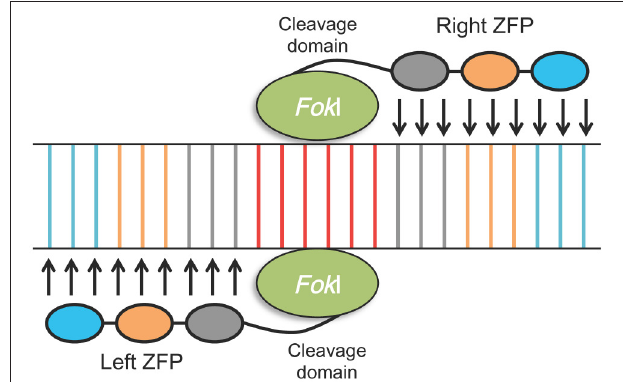
FIGURE 4 | Schematic illustration of zinc-finger nuclease (ZFN) structure and mechanism of inducing double strand breaks (DBSs) on its target. The target site of the ZFN is recognized by the “left” and “right” monomers consisting of a tandem array of three to six engineered zinc finger proteins (ZFPs) (three are shown here); single engineered ZFP can recognize a nucleotide triplet (shown in different colors). Each ZNF is linked to a nuclease domain from the Fok I restriction enzyme. Recognition of the target sequence by the left and right ZFPs results in dimerization of the Fok I nuclease; DNA cleavage takes place along the spacer sequence (usually 6 bp long, shown in red) between the two ZFP recognition